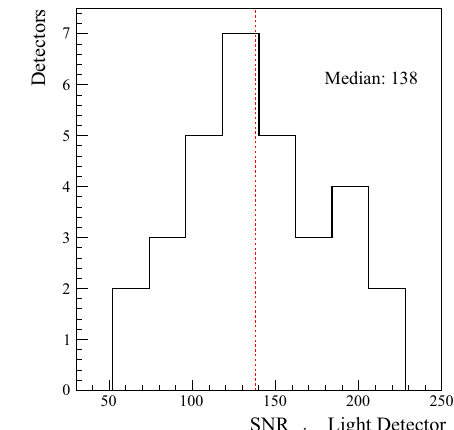
Fig. 27 Distribution of the LD SNRs. The signal amplitude is evalu- ated on test pulses generated by a current pulse through a Si resistor coupled to each LD. The amount of dissipated energy is the same for each